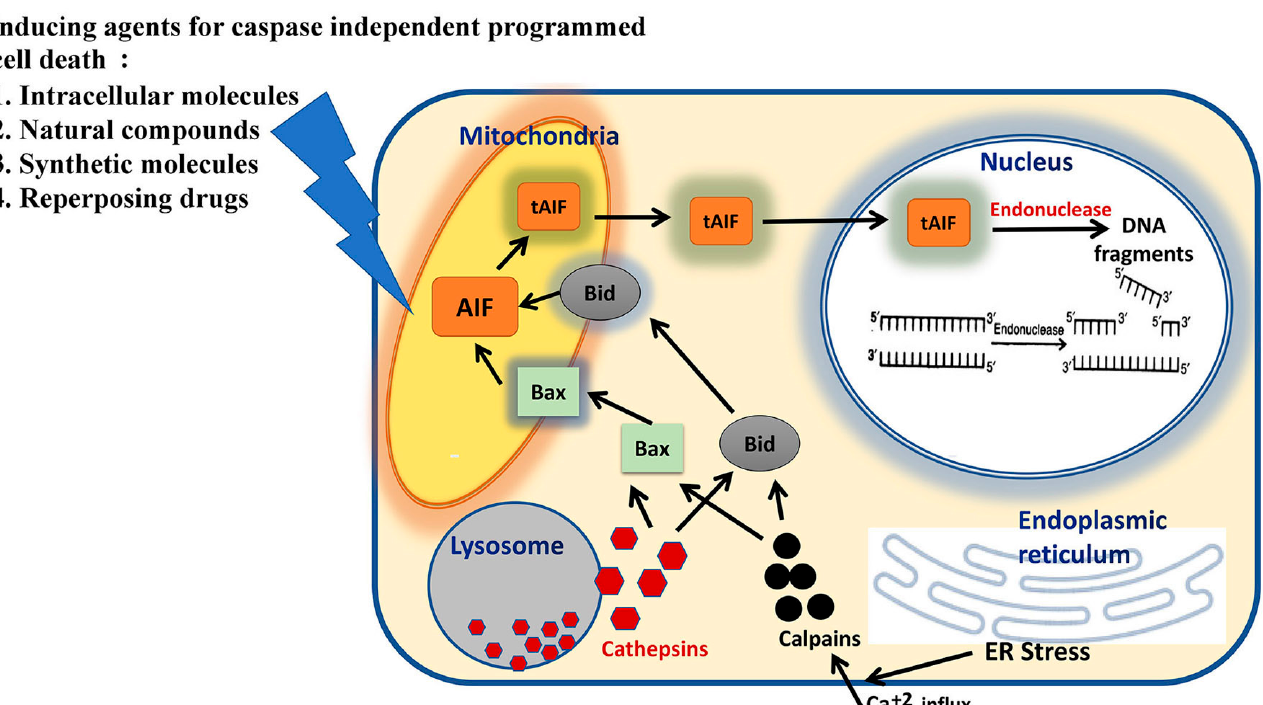
Figure 2. A schematic representation depicting the molecular pathways with the biomarkers of caspase-independent programmed cell death pathway. [Mitochondria is the main regulator which initiates number of events. In response to a stimulus, Bax, the pro-apoptotic protein, translocates to the mitochondrion. This translocation is controlled by cathepsins and calpains activity. Cathepsins are released from the lysosomes and calpains are activated by endoplasmic reticulum ER stress induced Ca 2+ influx in the cell. Cathepsins and calpains also cause cleavage and translocation of Bid to the mitochondrion and cleavage of AIF. The presence of Bax and cleaved Bid at the mitochondrial membrane induces mitochondrial depolarization, thereby causing increased membrane permeability, which, in turn, causes the release of cleaved AIF (sAIF) and Smac/DIABLO. sAIF translocates to the nucleus where it, jointly with endonuclease G, induces chromatin condensation and DNA fragmentation of high molecular weight fragments of ~50 kb].